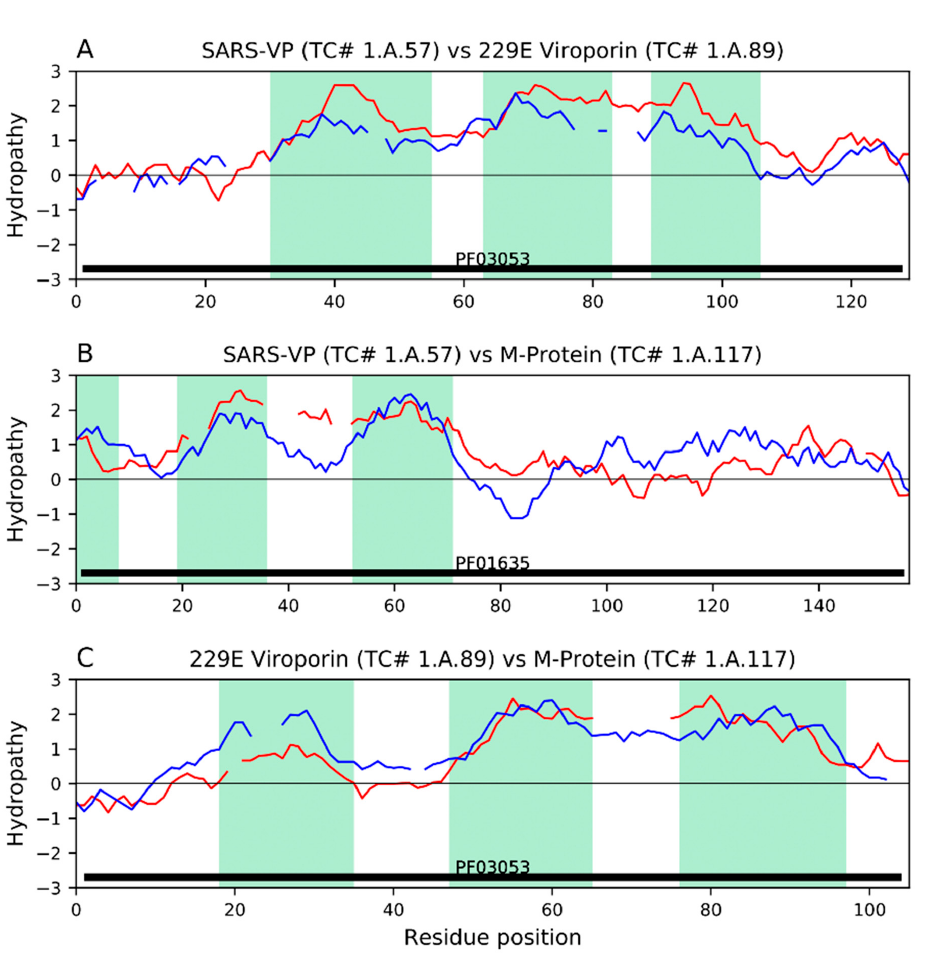
Figure 4. Topological relationships between (A) SARS-VP (3a) viroporins, 229E (4a) viroporins, and (C) M-proteins. Families were compared using our methodological pipeline based on the transitivity property of homology [249,250]. Hydrophobic peaks (inferred TMSs) are highlighted as green bars. Pfam domains were projected with the program GetDomainTopology [250] and drawn as solid black bars above the x -axis. ( A ) Hydropathy plots of representative alignments (E-value: 1.3 × 10 − 5 ) between a SARS-VP (3a) viroporin homolog AWV67041 (red) and a 229E (4a) viroporin homolog ADX59489 (blue). The characteristic Pfam domain of family 229E viroporins (PF03053) was projected to the SARS-VP homolog ADX59489 (E-value: 8.7 × 10 − 4 ). ( B ) Hydropathy plots of the representative alignments (E-value: 6.1 × 10 − 7 ) between a SARS-VP (3a) homolog ADX59475 (red) and an M-protein homolog ARI44791 (blue). The characteristic Pfam domain of the M-protein family (PF01635) was projected to the SARS-VP homolog ADX59475 (E-value: 4.8 × 10 − 3 ). ( C ) Hydropathy plots of the representative alignments (E-value: 1.4 × 10 − 6 ) between a 229E (3a) viroporin homolog ABQ57217 (red) and an M-Protein homolog YP_003858587 (blue). The characteristic Pfam domain of family 229E viroporin (PF03053) was projected to the M-protein homolog YP_003858587 (E-value: 1.4 × 10 − 3 ). Notice how the projected domains cover the entire length of the alignments in panels A-C. Altogether, the compatibility of TMS topologies (Figure 3) and the similarity of sequence characteristics between these three families suggest that they form a